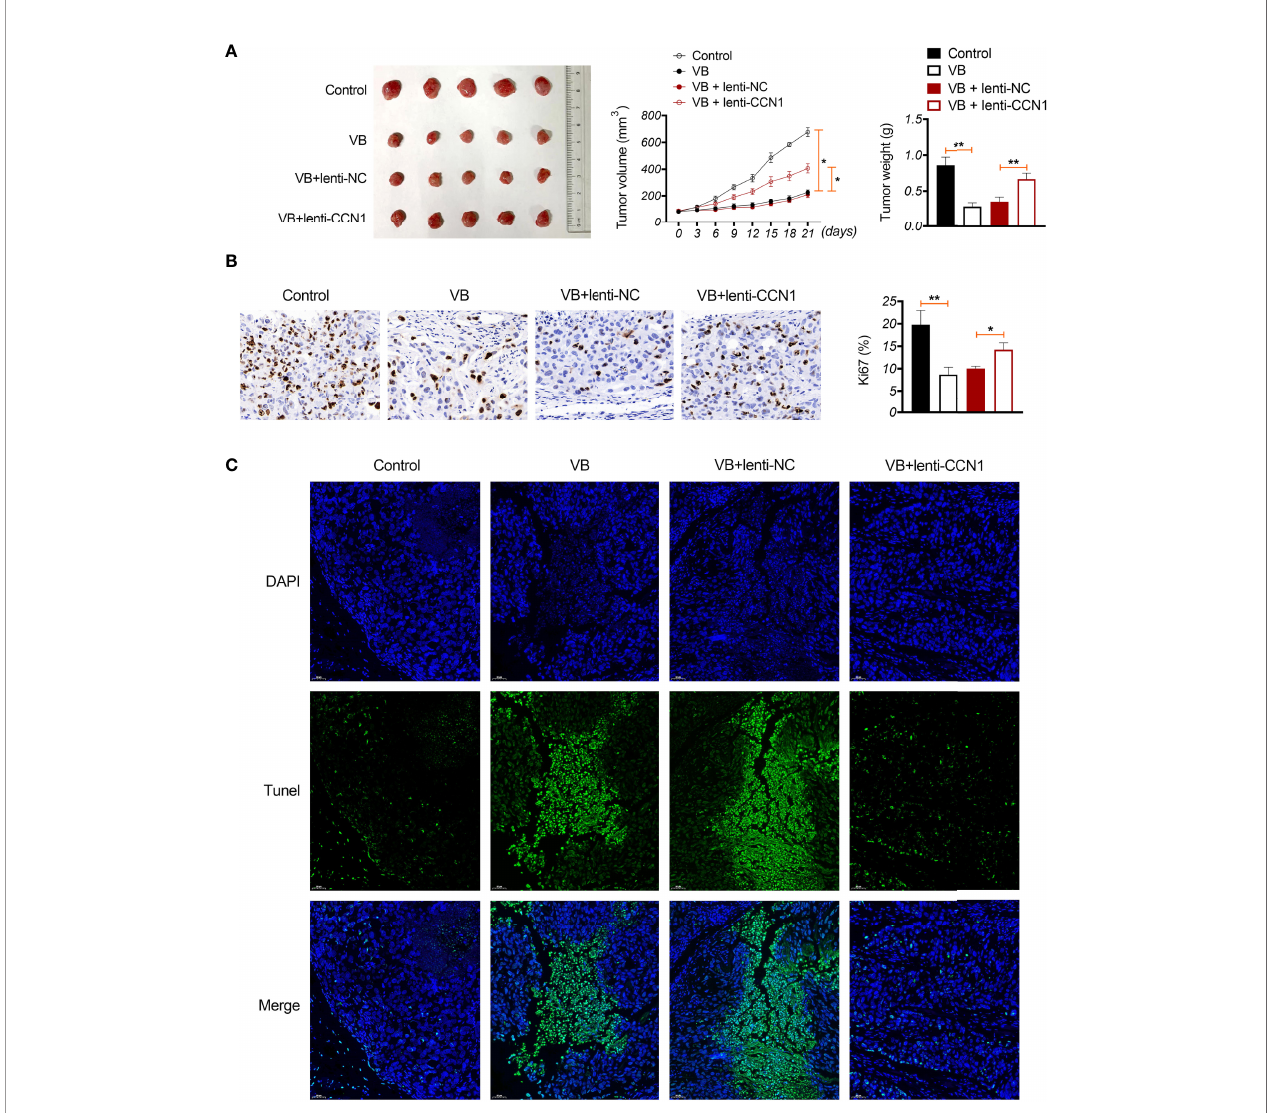
FIGURE 6 | VB inhibits tumour formation in vivo in OC. (A) A2780 cells were subcutaneously injected into the right fl ank of nude mice to establish a tumour xenograft model. The tumour volume and weight were recorded. (B) Ki-67 expression in OC tissues. Scar bar = 50 µm. (C) Apoptosis was identi fi ed using TUNEL assay. Scar bar = 50 µm. Error bars represent mean ± SD; * P < 0.05 and ** P <